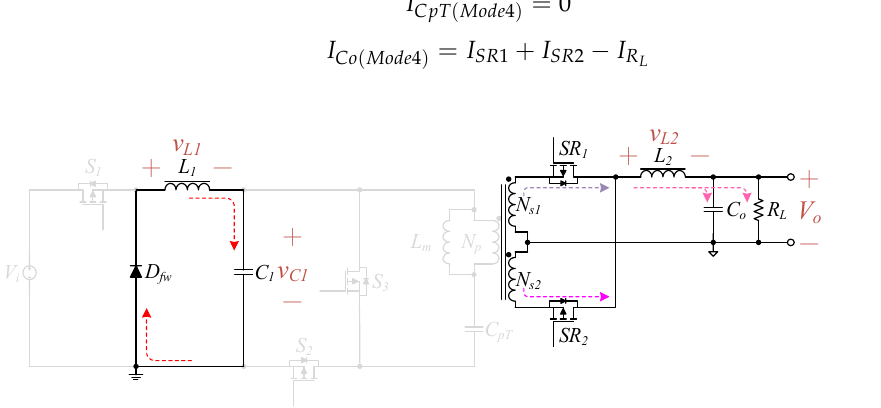
Figure 10. The switches SR 1 and SR 2 are in the turned-on state.